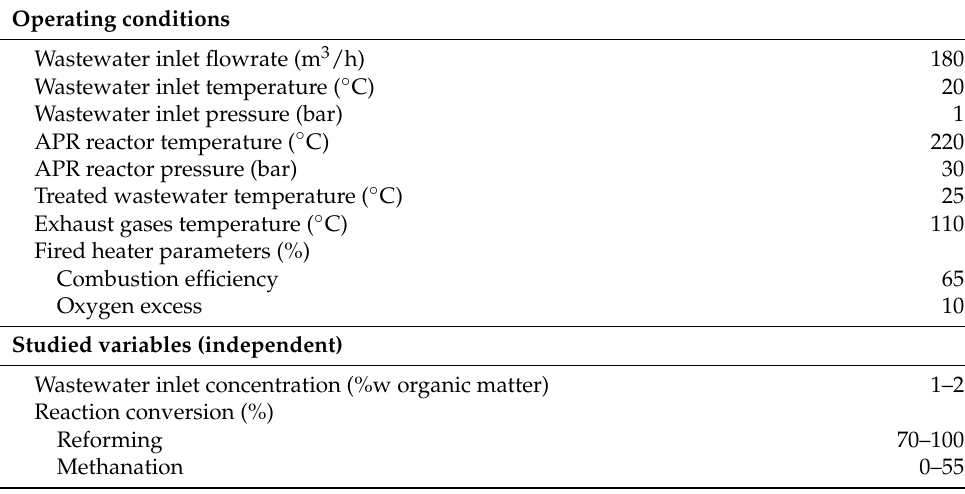
Table 2. Operating conditions and studied variables for process heat balance